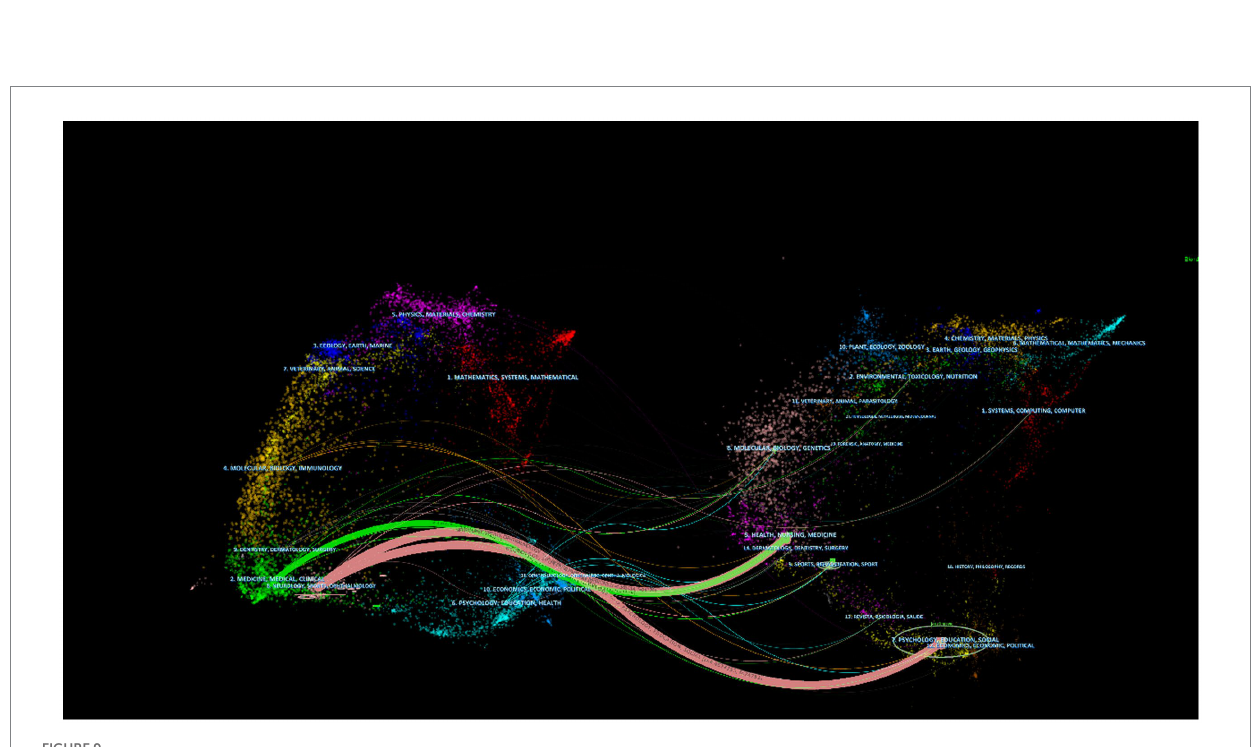
FIGURE 9 The dual-map overlay of journals with